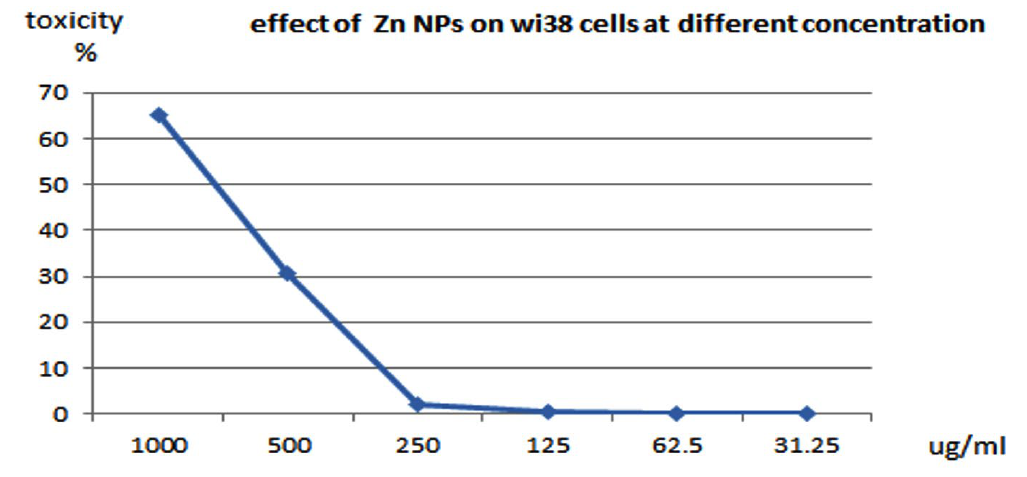
Fig. 17. Effect of ZnONP on wi38 cells at different